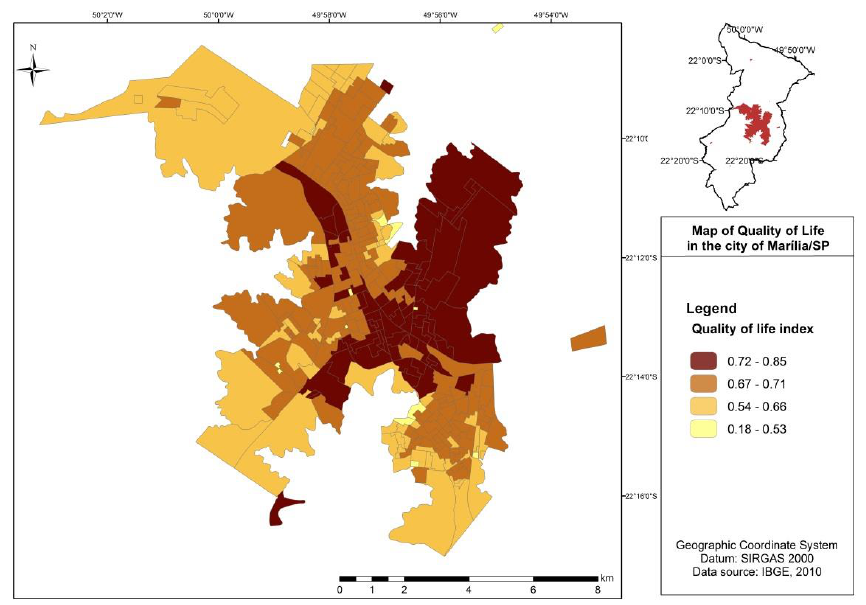
Figure 9. Quality of life index map.